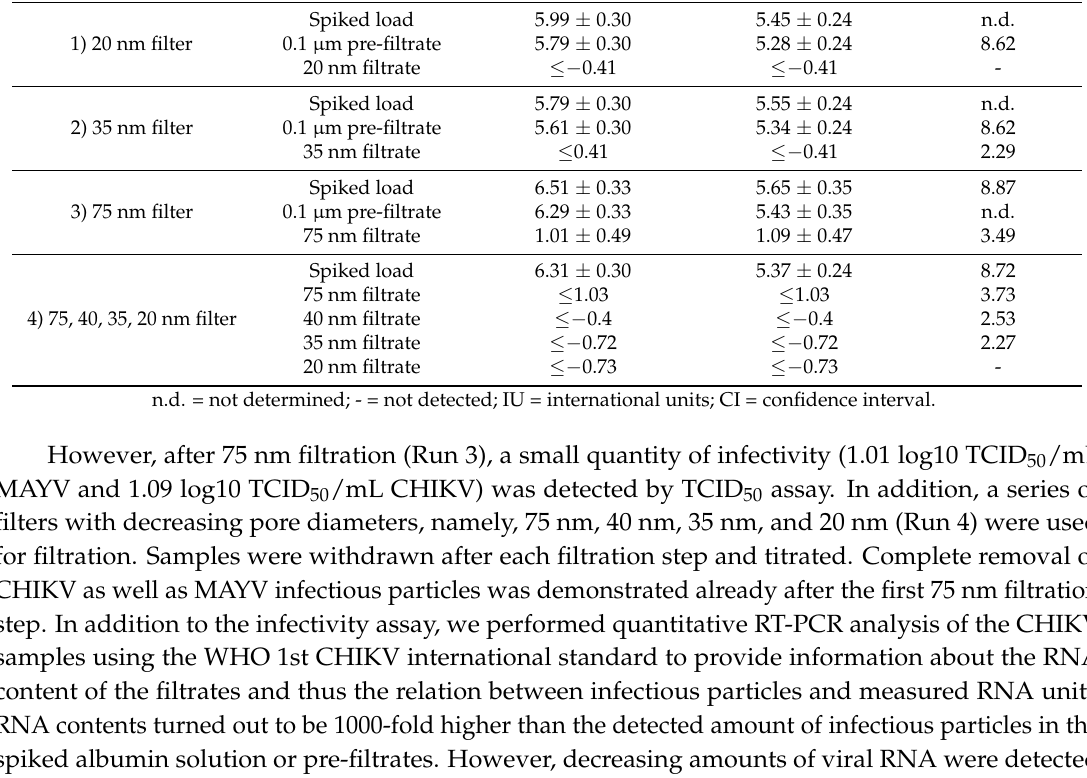
Table 1. Reduction of viral particles and viral RNA content by nanofiltration. Run Sample